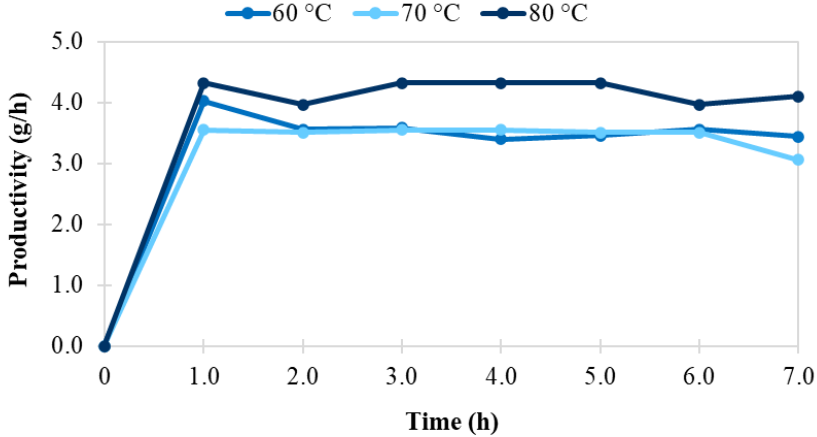
Figure 12. Productivity (g/h) in the continuous enzymatic synthesis of n -amyl caproate in solventless system catalyzed by sol-gel-entrapped Candida antarctica B lipase at a flow rate of 0.4 mL/min, a substrate molar ratio of 2:1 and different temperatures.